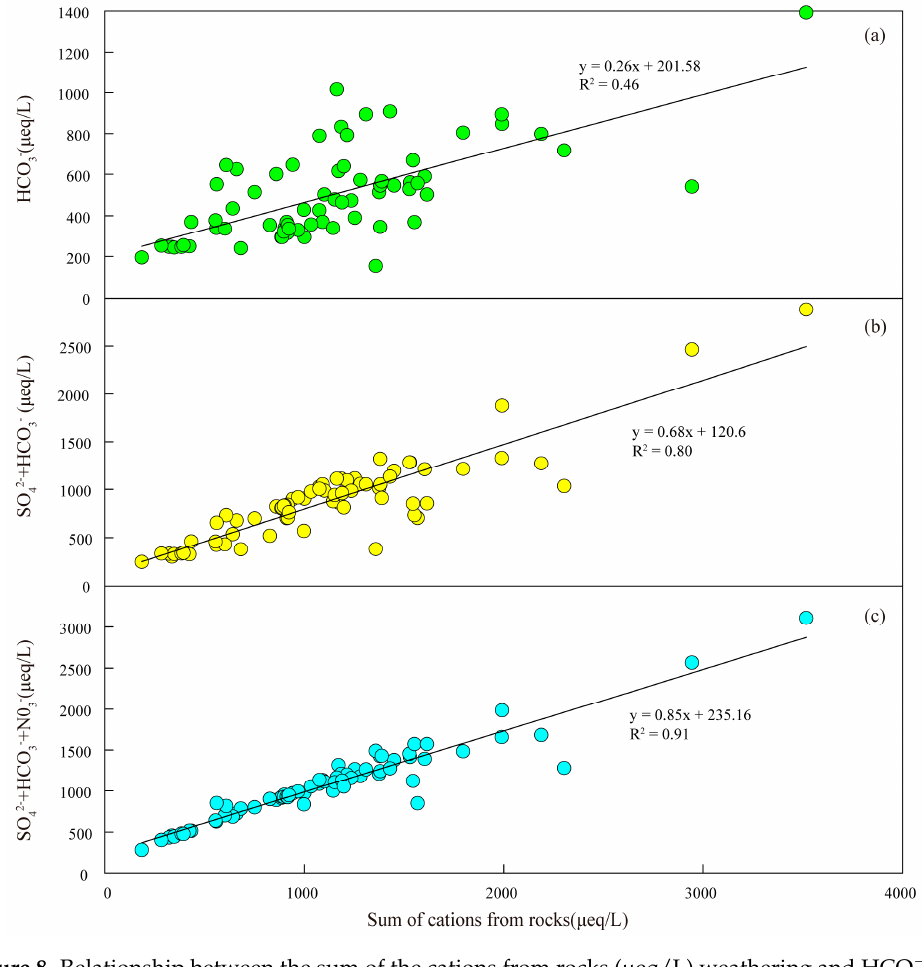
Figure 8. Relationship between the sum of the cations from rocks ( μ eq/L) weathering and HCO 3 (cid:2879) ( a ), − + SO 2 − ( b ), and HCO − and HCO 3 (cid:2879) + SO 42 (cid:2879) ( b ), and HCO 3 (cid:2879) + SO 42 (cid:2879) + NO 3 (cid:2879) ( c ) in the JR. and HCO 3 4